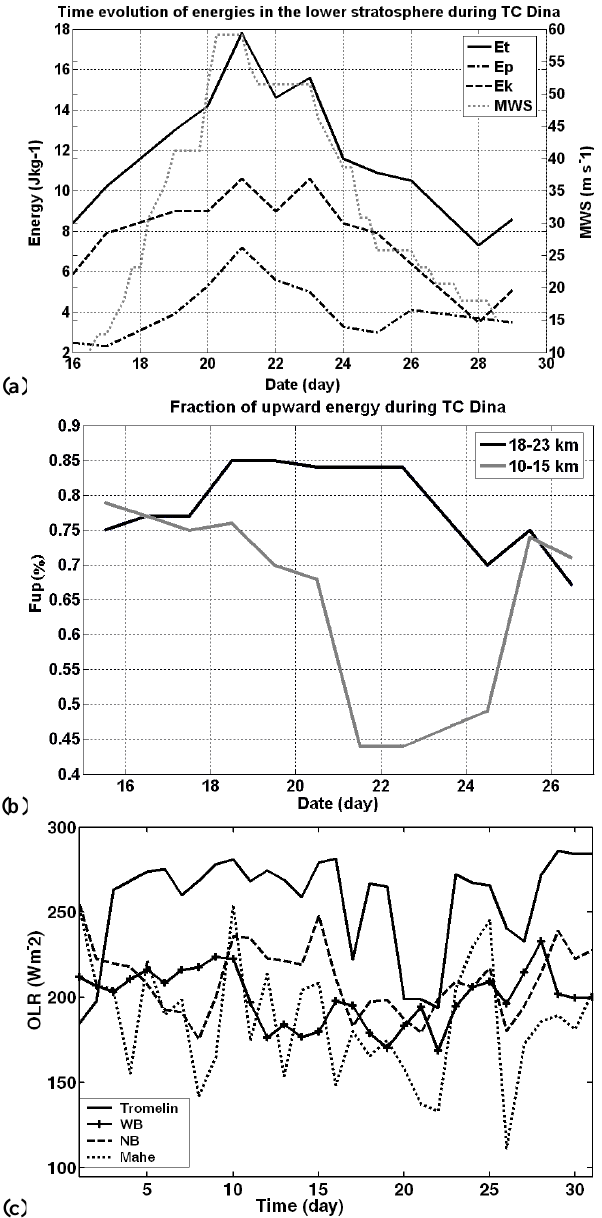
Fig. 8. Time evolution of (a) total, potential and kinetic energy den- sities and the maximum wind speed of TC Dina (MWS), (b) frac- tion of upward energy in the UT (10–15km) and the LS (18–23km) from 16 to 29 January 2002 and (c) Time series of OLR over Tromelin (2.5 ◦ radius), Mahe (2.5 ◦ radius), the west part of the basin (25 ◦ –35 ◦ E, 0 ◦ –15 ◦ S) and the north part of the basin (50 ◦ – 60 ◦ E, 0 ◦ –10 ◦